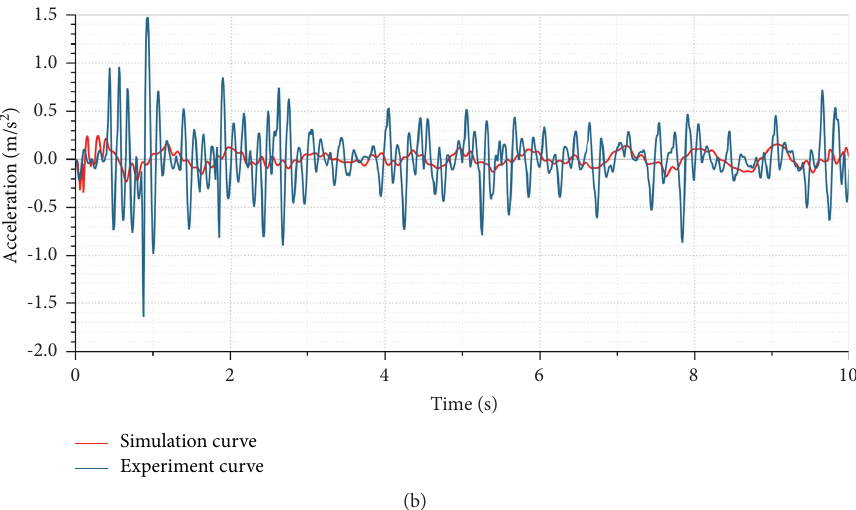
Figure 14: Comparison curve between experiment and simulation. (a) Displacement curve. (b) Acceleration curve.